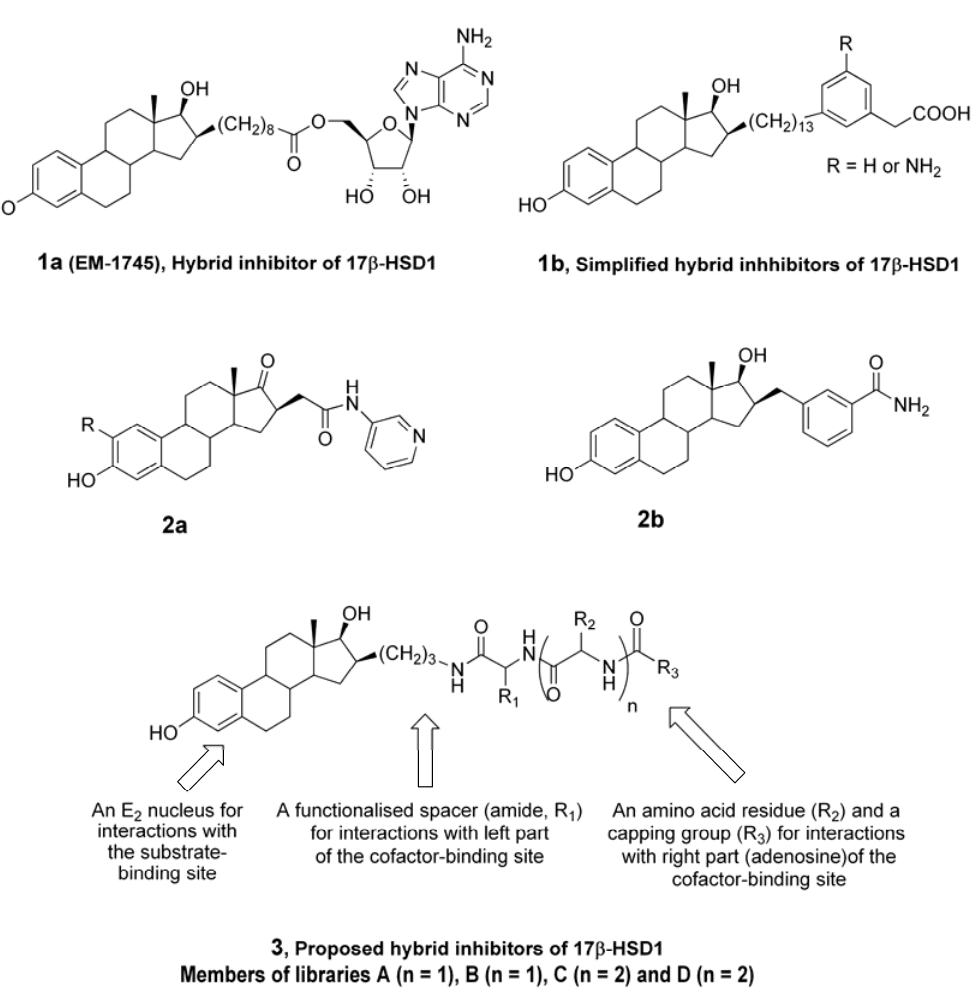
Figure 2. Bisubstrate hybrid inhibitors 1a and 1b , simplified inhibitors 2a and 2b , and general structure 3 of proposed inhibitors of 17 β